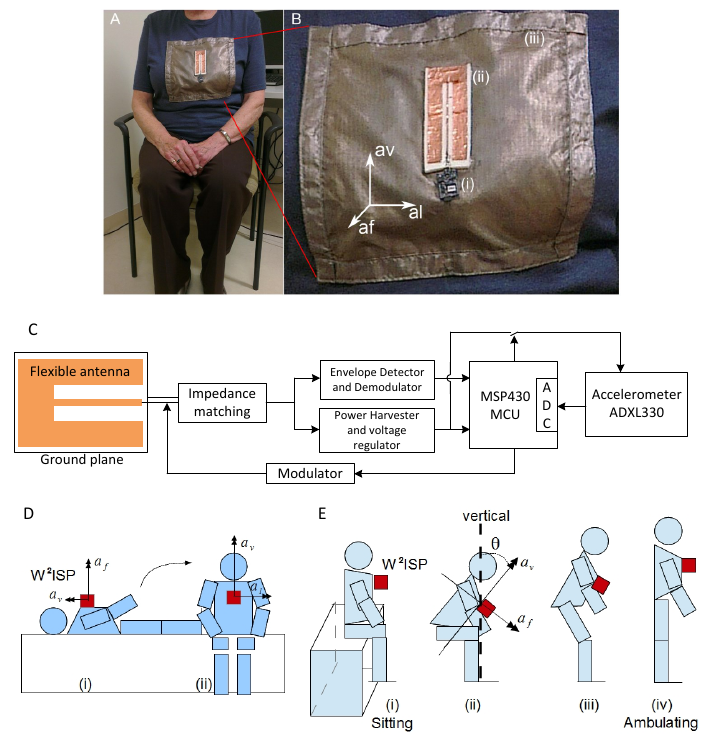
Figure 3. Wearable Wireless Identification and Sensing Platform (W 2 ISP). ( A ) older volunteer wearing device on top of clothing; ( B ) W 2 ISP parts: (i) circuitry, 18 × 20 × 2mm; (ii) flexible antenna, 36 × 85 × 2mm; and (iii) isolating silver coated fabric, 230 × 220mm; ( C ) block diagram of W 2 ISP platform; ( D ) process of lying on bed to sitting on bed; and ( E ) process of sitting (in bed or chair) to